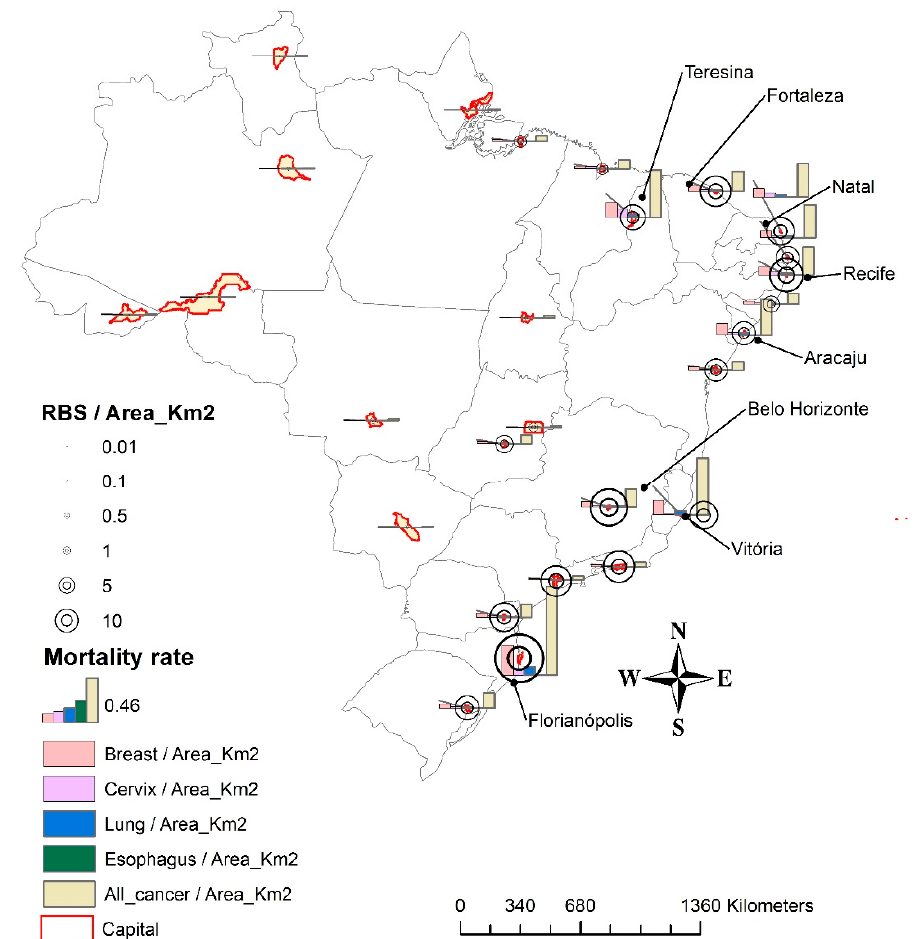
Figure 1. Distribution of the cancer mortality rate in each capital and their experience of exposure to radio base stations radiofrequency, 2010–2017. RBS = median of the number of radio base station radiofrequency exposure (RBS radiofrequency exposure = sum of the number of RBS in each year multiplied by the exposure time). RBS/Area_Km2 = median of the number of RBS per Km 2 . We used the median of mortality rate. Breast/Area_K2, Cervix/Area_K2, Lung/Area_K2, or Esophagus/Area_K2 = median mortality rate for a specific cancer type per Km 2 .